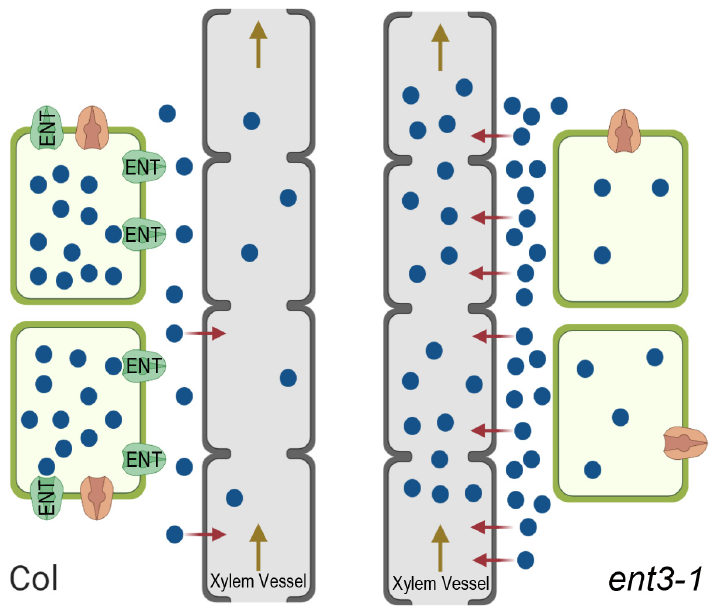
Figure 6. Scheme showing ENT-mediated uptake of externally supplied cytokinin riboside (blue circles) by living root cells, their passive loading into the dead xylem vessels (red arrows), and their flow to the shoot within the transpiration stream (brown arrow) in wild type Col plants (left) and ent3-1 mutant (right). In Col, uptake and retention of cytokinin ribosides by living root cells occurs at a high rate resulting in a decreased apoplastic concentration, low loading into xylem vessels through the apoplast route, and reduced export to the shoots with the transpiration stream. In the ent3-1 mutant cellular uptake of cytokinin riboside is reduced resulting in increased apoplast concentration, higher loading into the xylem apoplast, and greater export to shoots. Equivalent effects on endogenous cytokinins would indicate that the fully functional ENT3 carrier helps suppress losses to the shoot thereby maintaining the cytokinin titer of growing root cells at optimal